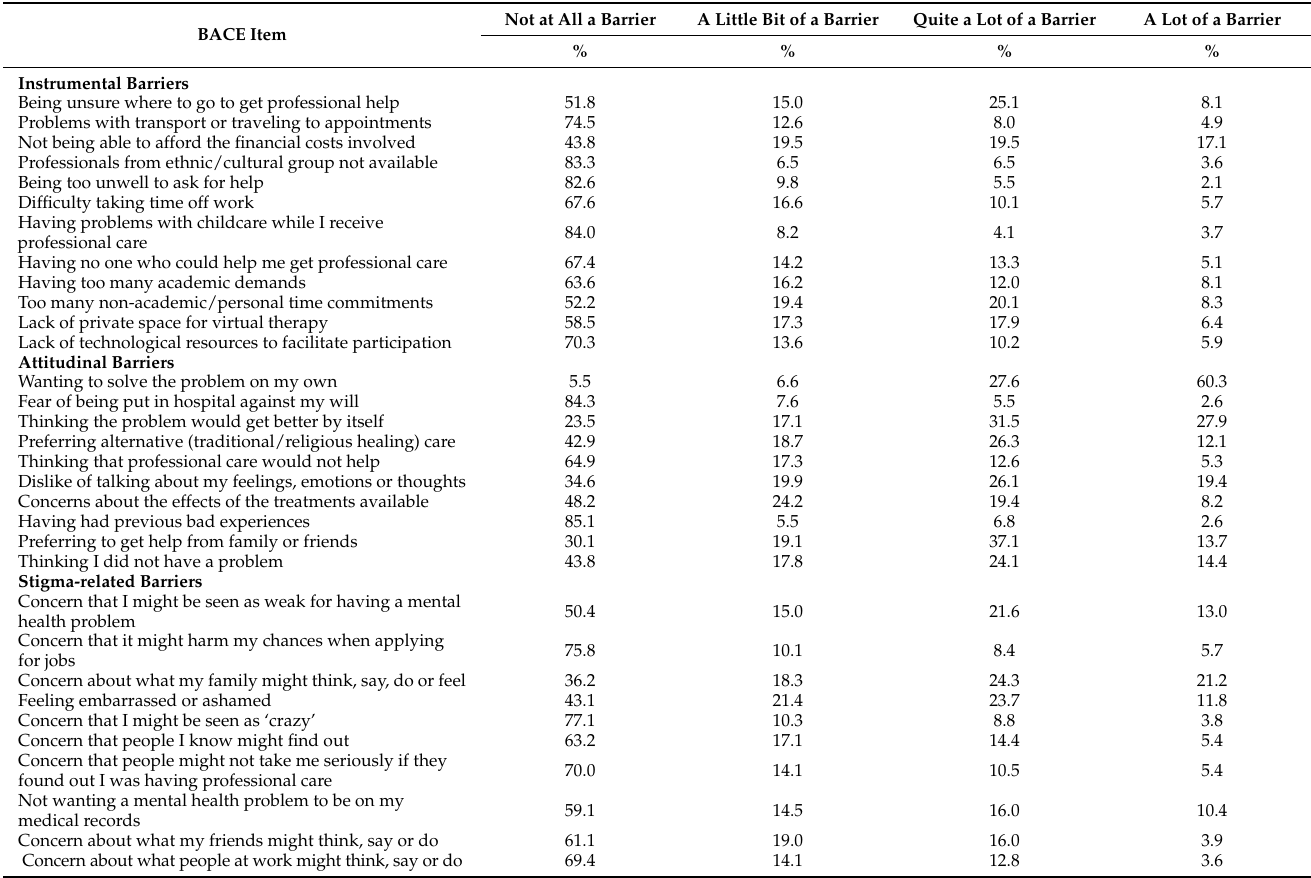
Table 1. Types of Barriers to Accessing Care (% of sample endorsing